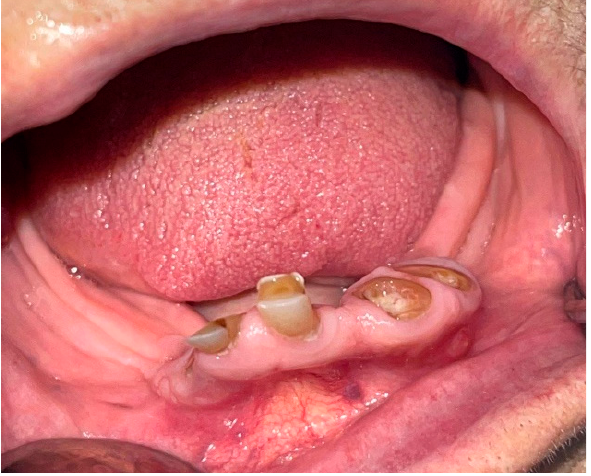
Figure 1. The features of the mandible incisors and the mandibular edentulous ridge.